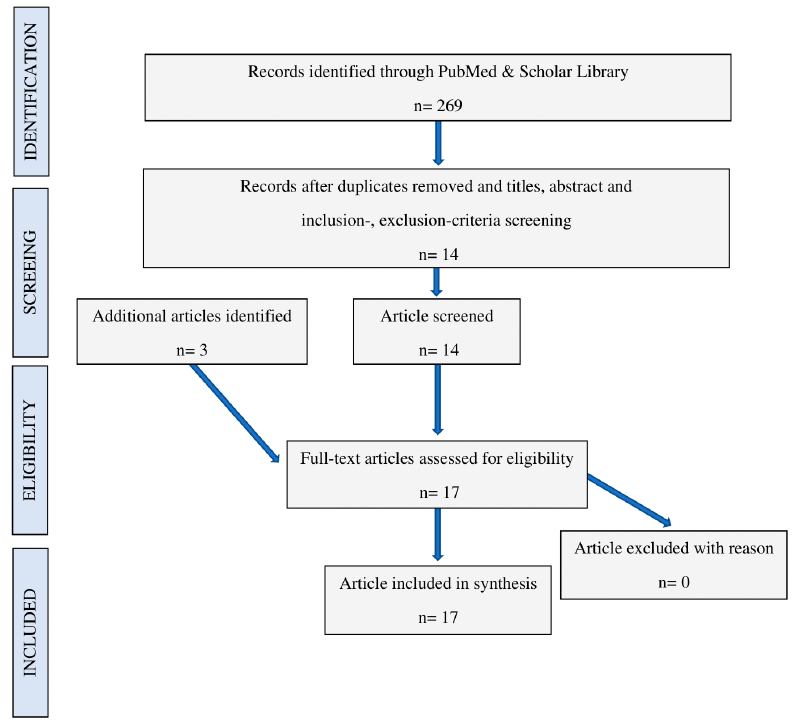
Figure A1. Flow chart demonstrating the selection process.